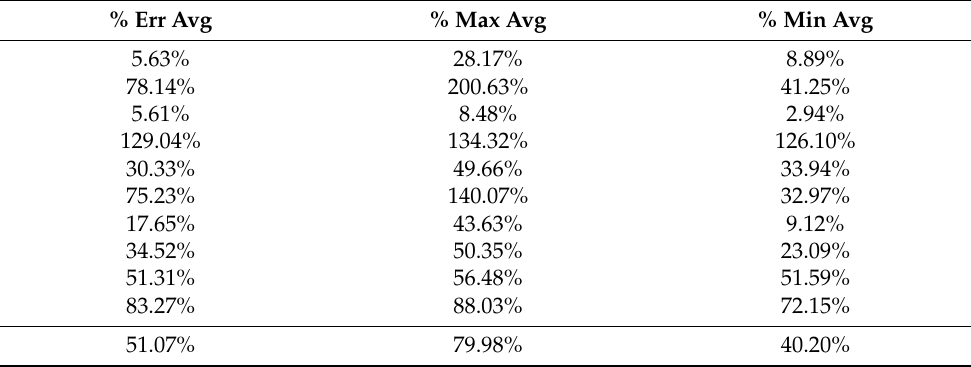
Table A12. Set 1, trials 1–10 data (average actual PR values).